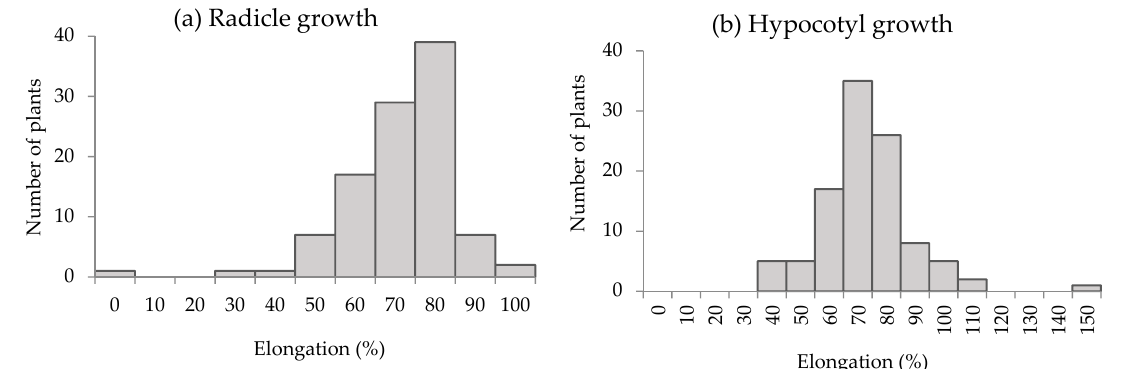
Figure 4. Effect of volatile allelopathic potentialities of 103 plant specimens on test plant ( L. sativa ) ( a ) radicle elongation and ( b ) hypocotyl elongation.